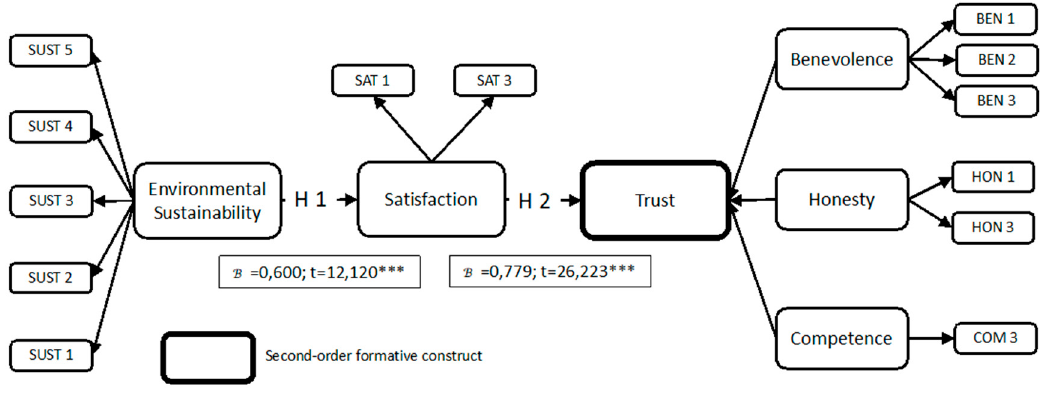
Figure 2. Proposed research model results.